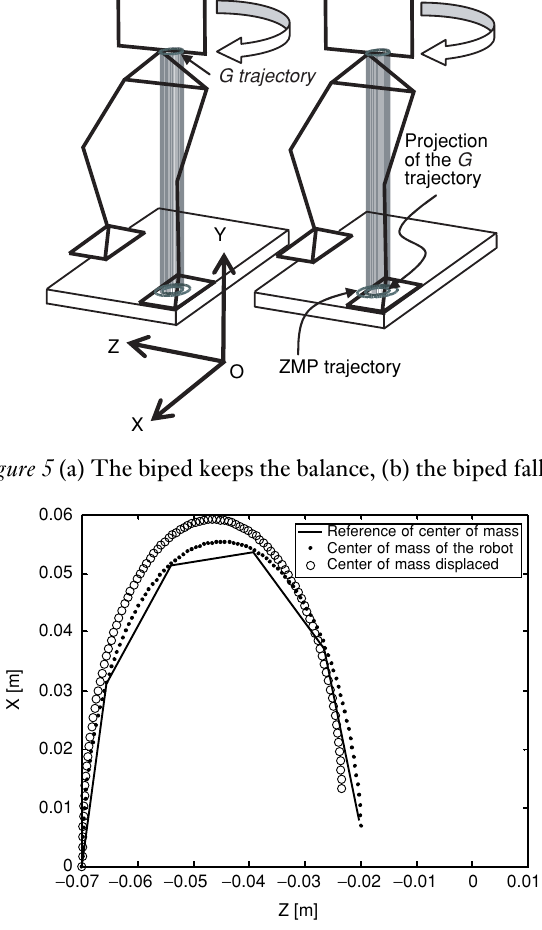
Figure 6 Effect on the trajectory of the center of mass G of the robot when the technique is applied.